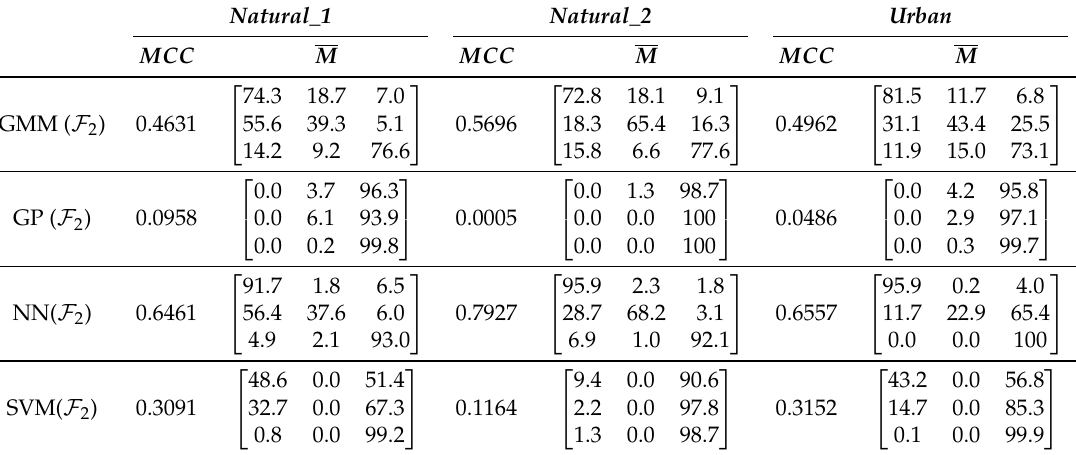
Table 2. Performance of classifiers ( MCC and M ) using feature vector definition F 2 for the evaluation